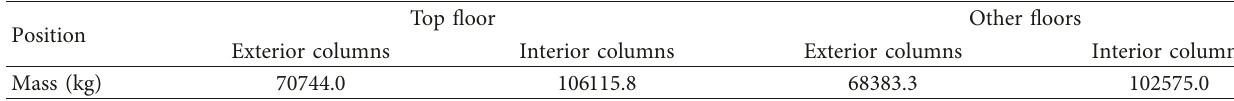
Table 3: Masses at the nodes of the frame.